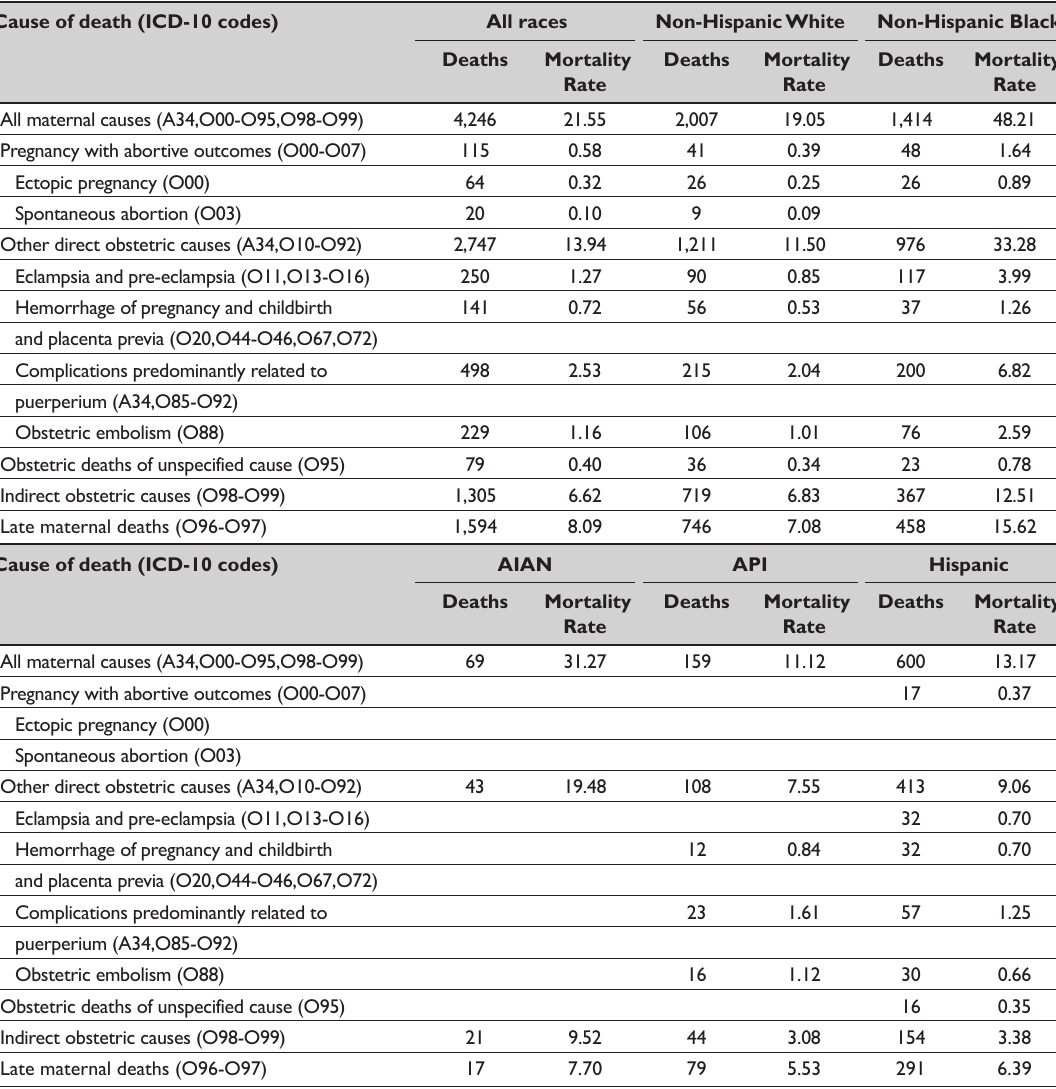
Table 3: Number of maternal deaths and maternal mortality rates per 100,000 live births for selected causes by race/ethnicity, United States, 2013-2017 Cause of death (ICD-10 codes) All races Non-Hispanic White Non-Hispanic Black